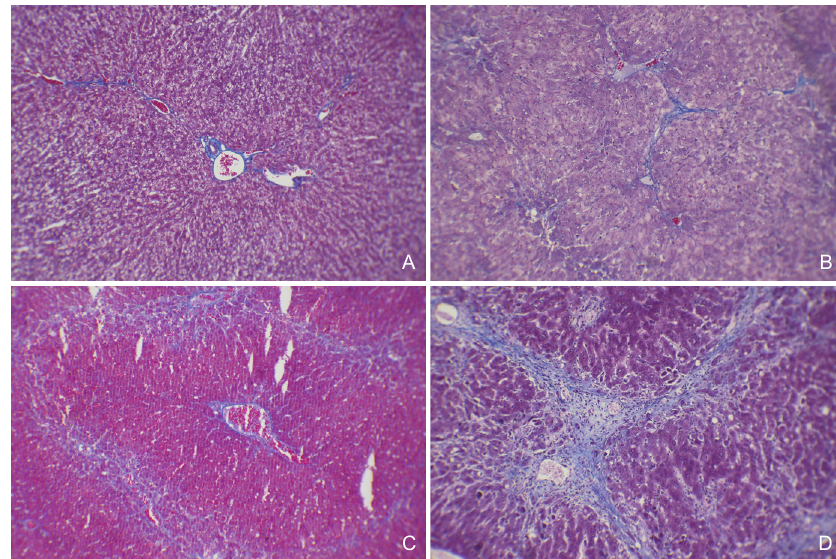
C Figure 1 Histological findings of different degrees of liver cirrhosis by Masson staining (× 100). (A) Control group; (B) 6-week group; (C) 12-week group; (D) 18-week group.